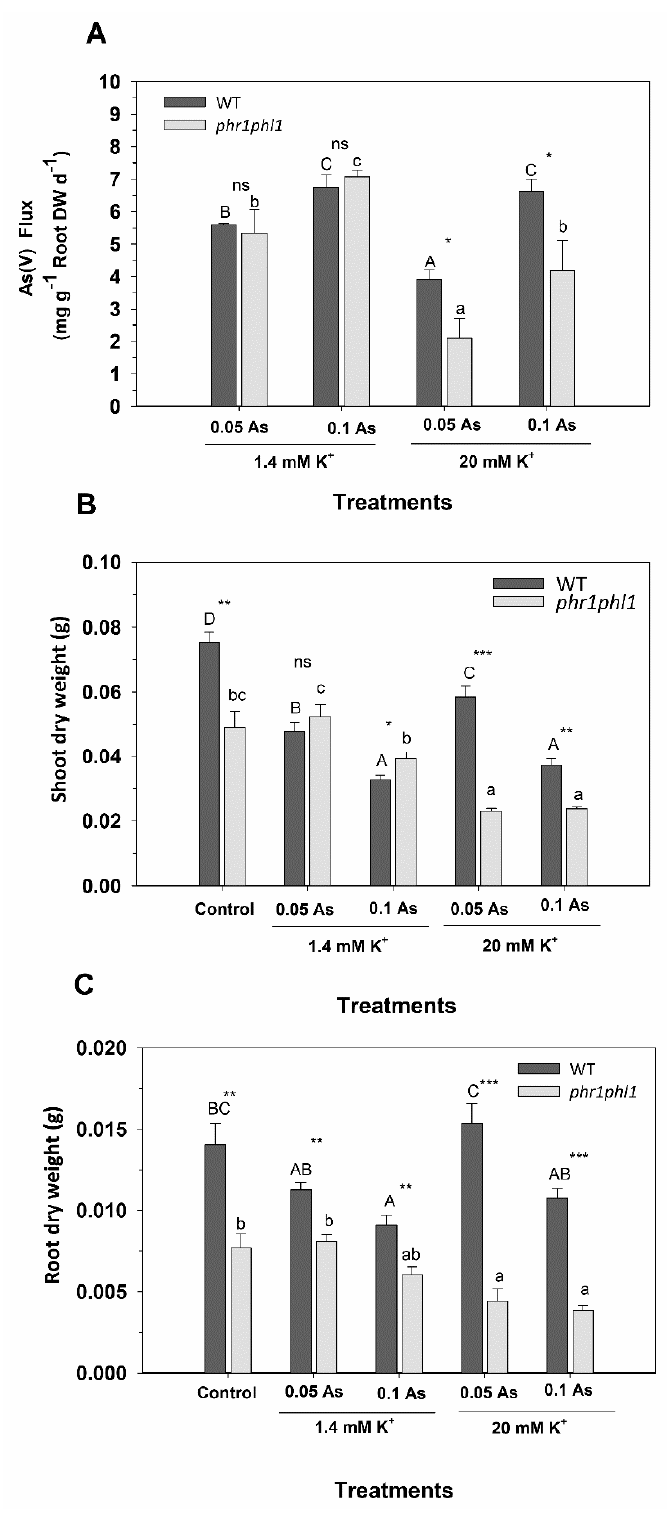
Figure 7. As(V) fluxes and shoots and roots dry weights of plants exposed to different concentrations of As(V) and K + . Plants of WT (dark grey bars) and phr1phl1 mutant (light grey bars) were grown for 33 days in a control 1/5 Hoagland solution containing 0.05 mM Pi and then transferred for 1 day to solutions containing 0.05 mM Pi with 0.05 or 0.1 mM As(V) in the presence of 1.4 or 20 mM K + . Then shoots and roots were harvested, dried at 65 °C, acid digested, and their arsenic concentrations determined by ICP spectrometry. The arsenic fluxes ( A ) were calculated from the arsenic accumulation in the plant per day and gram of root dry weight. The average shoot ( B ) and root ( C )